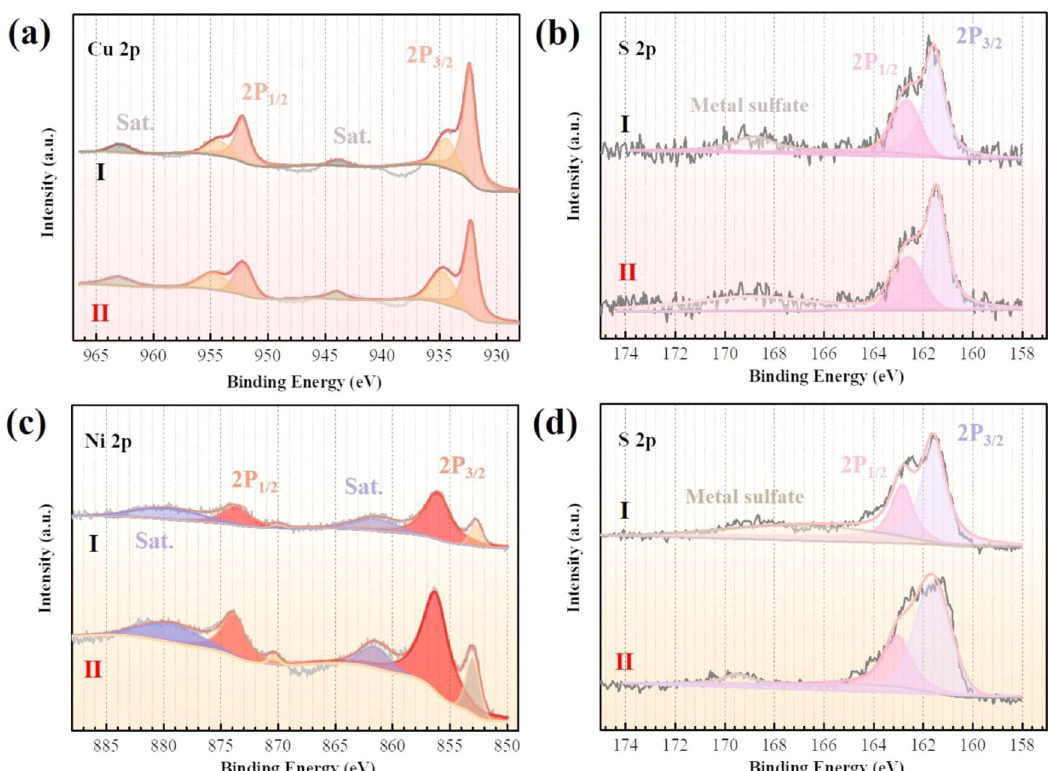
Fig. 5 XPS. XPS spectra of corrosion products on the surface of Cu and Ni coupons after the 7-d incubation in the D. vulgaris media without (I) and with (II) ribo fl avin: a Cu 2 p , b S 2 p , c Ni 2 p , d S 2 p .